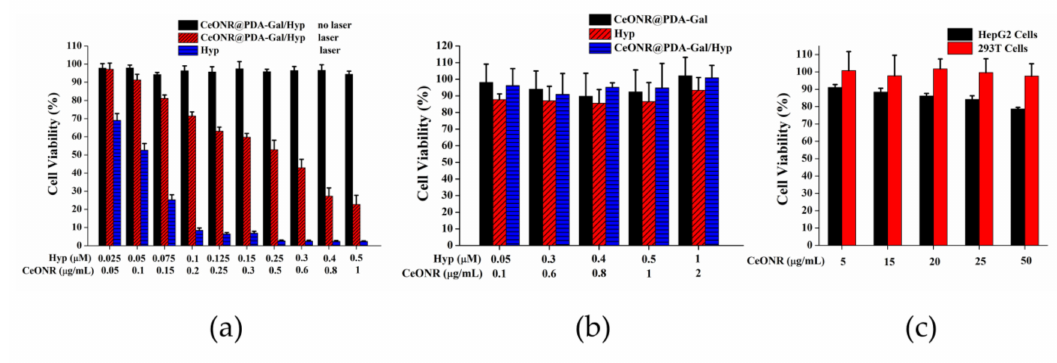
Figure 6. ( a ) The cell viability of HepG2 cells, which were co-cultured with Hyp and CeONR@PDA-Gal / Hyp (Hyp 0.025–0.5 µ M) for 4 h, respectively, irradiated with a 590-nm light source (8.6 mW / cm 2 ) for 30 min, and then cultured for 24 h in the dark. HepG2 cells co-cultured with CeONR@PDA-Gal / Hyp at the same concentrations for 28 h in the dark were used as control. ( b ) The cell viability of 293T cells treated with di ff erent concentrations of free Hyp, CeONR@PDA-Gal, and CeONR@PDA-Gal / Hyp, respectively, without laser exposure for 24 h. ( c ) The cell viability of HepG2 cells and 293T cells treated with CeONR@PDA-Gal at various doses (CeONR 5–50 µ g / mL) without laser